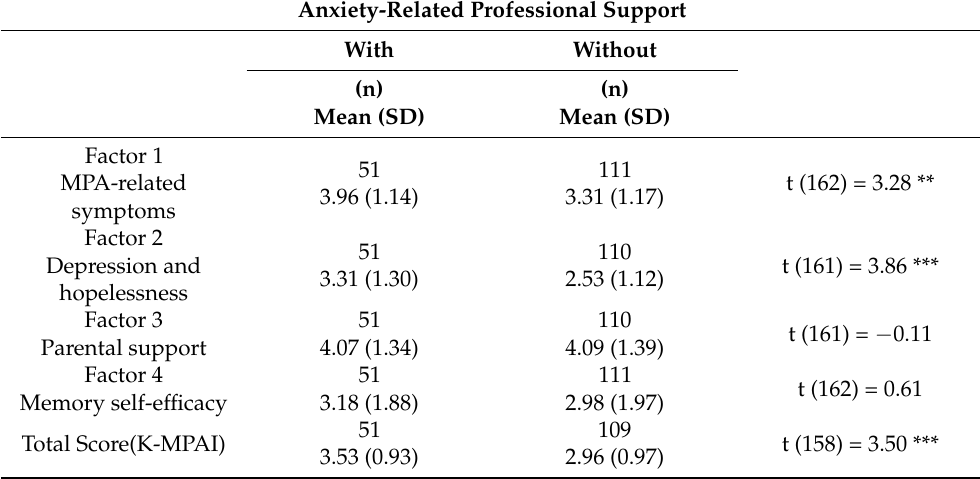
Table 5. Differences between participants with and without a history of anxiety-related professional support (K-MPAI dimensions and total score).